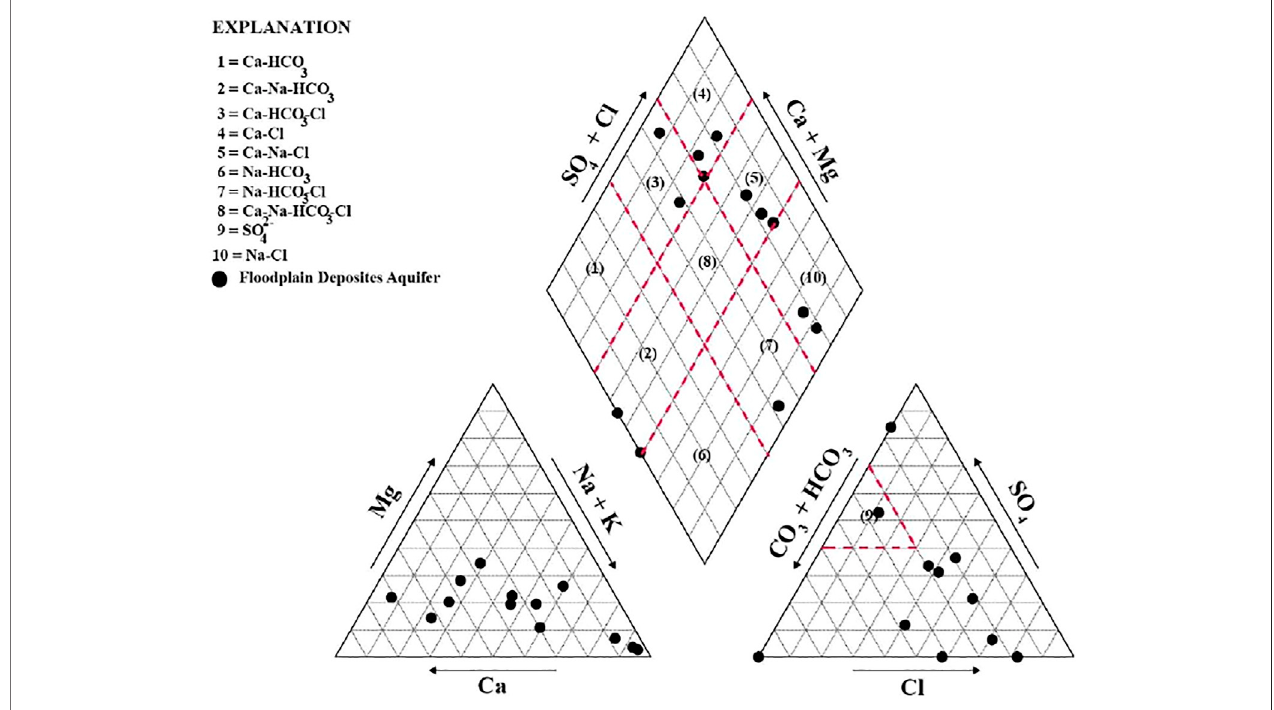
FIGURE 3 | Piper diagram indicating water types of groundwater samples.